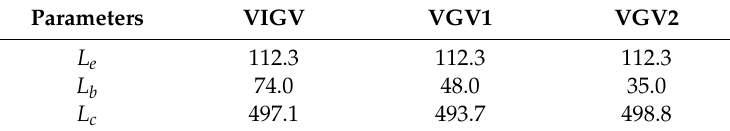
Table 4. Geometry parameters of the initial link mechanism (unit: mm).